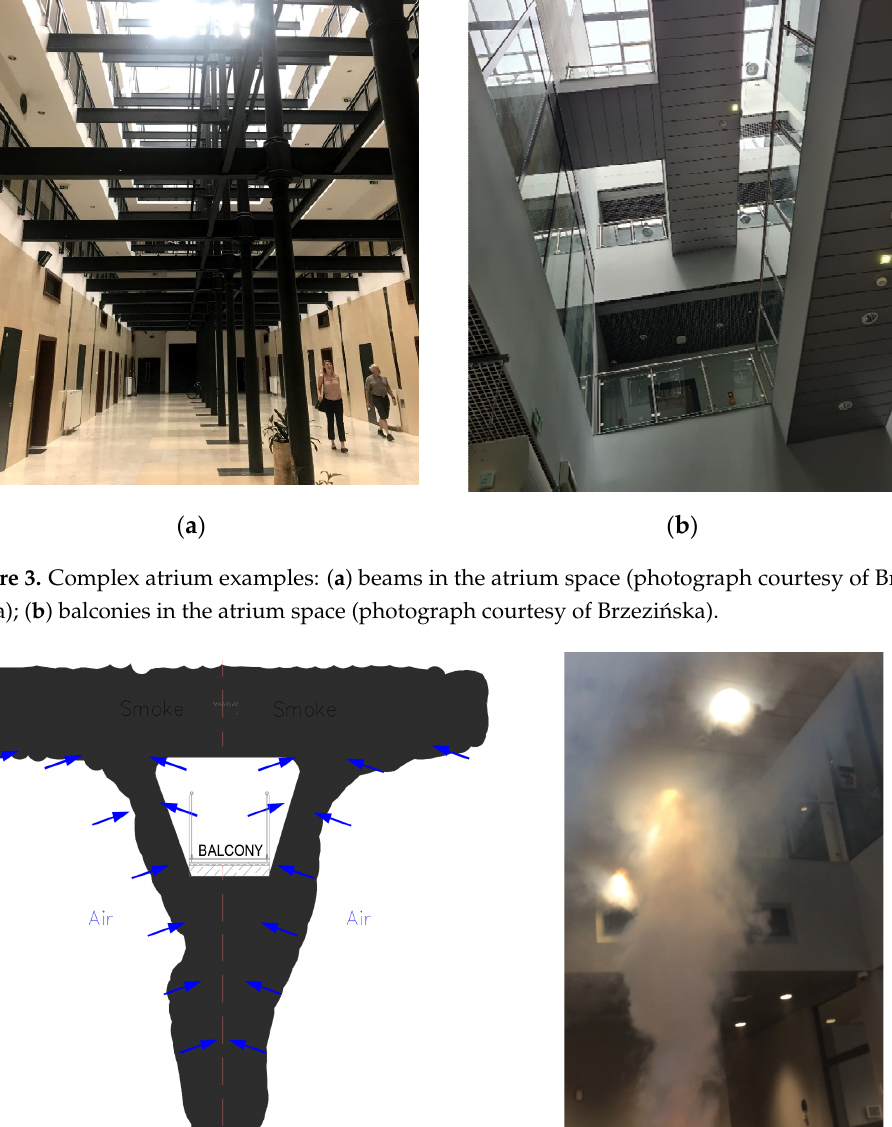
Figure 4. A multiplied convective smoke column: ( a ) a theoretical smoke column under a balcony shape; ( b ) a photograph of a smoke column under a balcony from the smoke test (photograph courtesy of Brzezi ń ska).